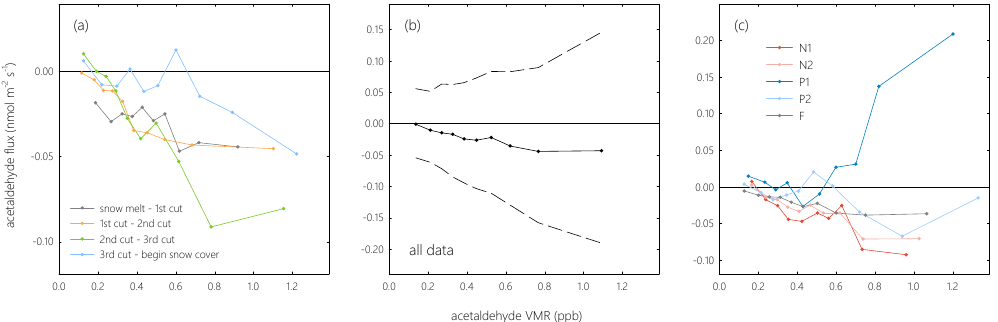
Figure 8. Bin averages of half-hourly acetaldehyde volume mixing ratio (VMR) and flux (a) during different time periods and over all 4 years (551–725 values per bin), (b) using all available data from all 4 years (2542 values per bin) and (c) in groups defined by the direction of correlation and goodness of fit between half-hourly acetaldehyde VMRs and fluxes: N1...negative slope, r 2 > 0 . 2, N2...negative slope, 0 . 05 < r 2 < 0 . 2, P1...positive slope, r 2 > 0 . 2, P2...positive slope, 0 . 05 < r 2 < 0 . 2, F ...zero slope, r 2 < 0 . 05. All management data were excluded form the analysis.